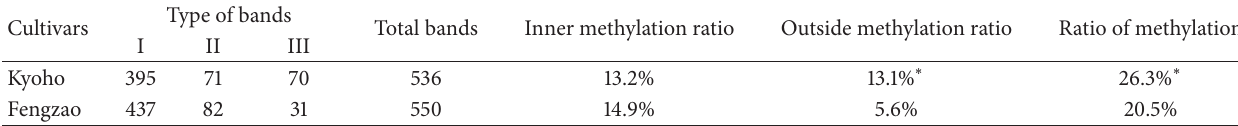
Table 4: Results of MSAP analysis of genome DNA methylation of grape varieties.